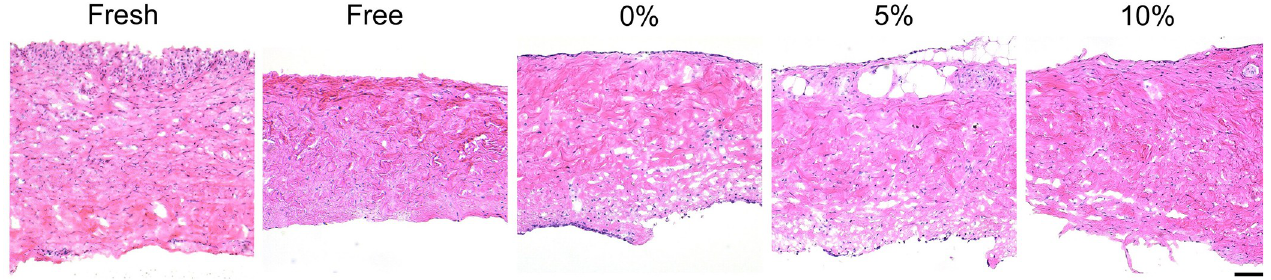
Fig 3. Anatomy of periosteal tissue prior to and following in vitro culture. H&E stained sections of fresh porcine periosteal tissue and periosteum after 10 days in culture. Scale bar = 100 μ m.